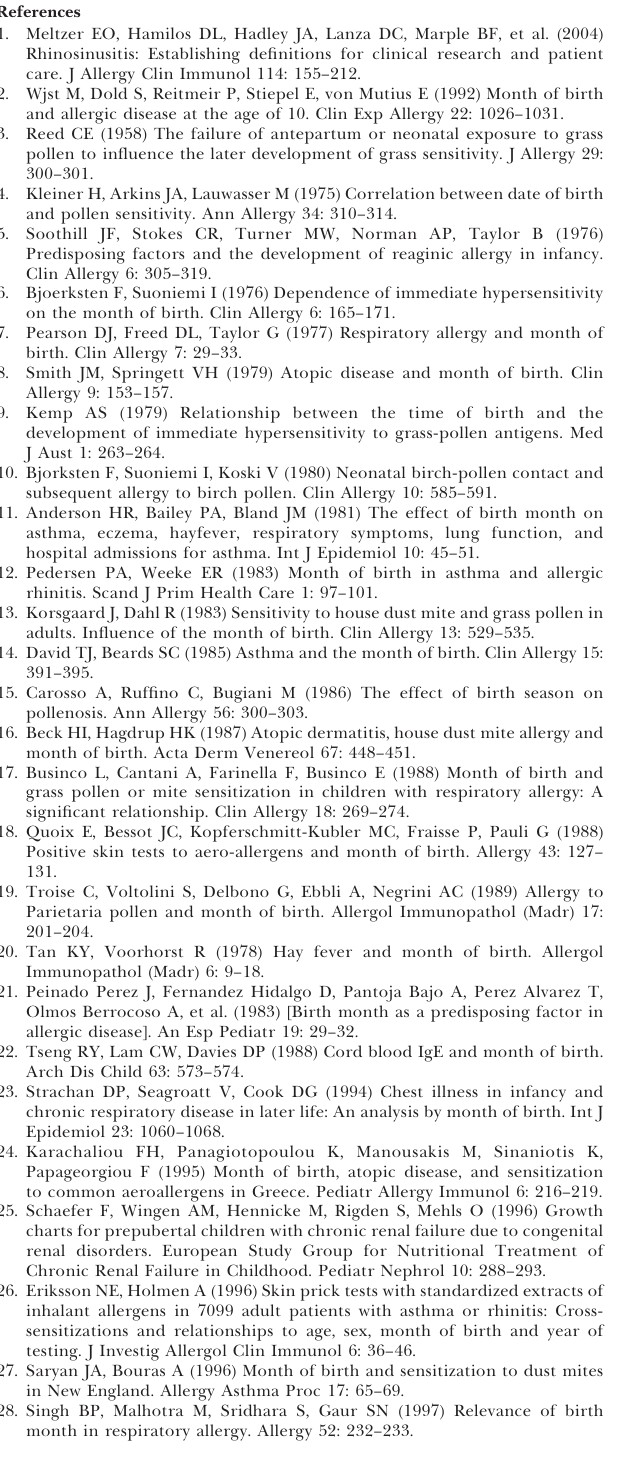
Figure S20. ECRHS I Main Median Log Total IgE by Month and Year of Birth Found at DOI: 10.1371/journal.pmed.0020294.sg020 (67 KB PDF) Figure S21. ECRHS I Main Median Log Total IgE by Month and Quarter of Birth Found at DOI: 10.1371/journal.pmed.0020294.sg021 (66 KB PDF) Figure S22. ECRHS I Main Median Log Total IgE by Absolute Latitude and Language Found at DOI: 10.1371/journal.pmed.0020294.sg022 (58 KB